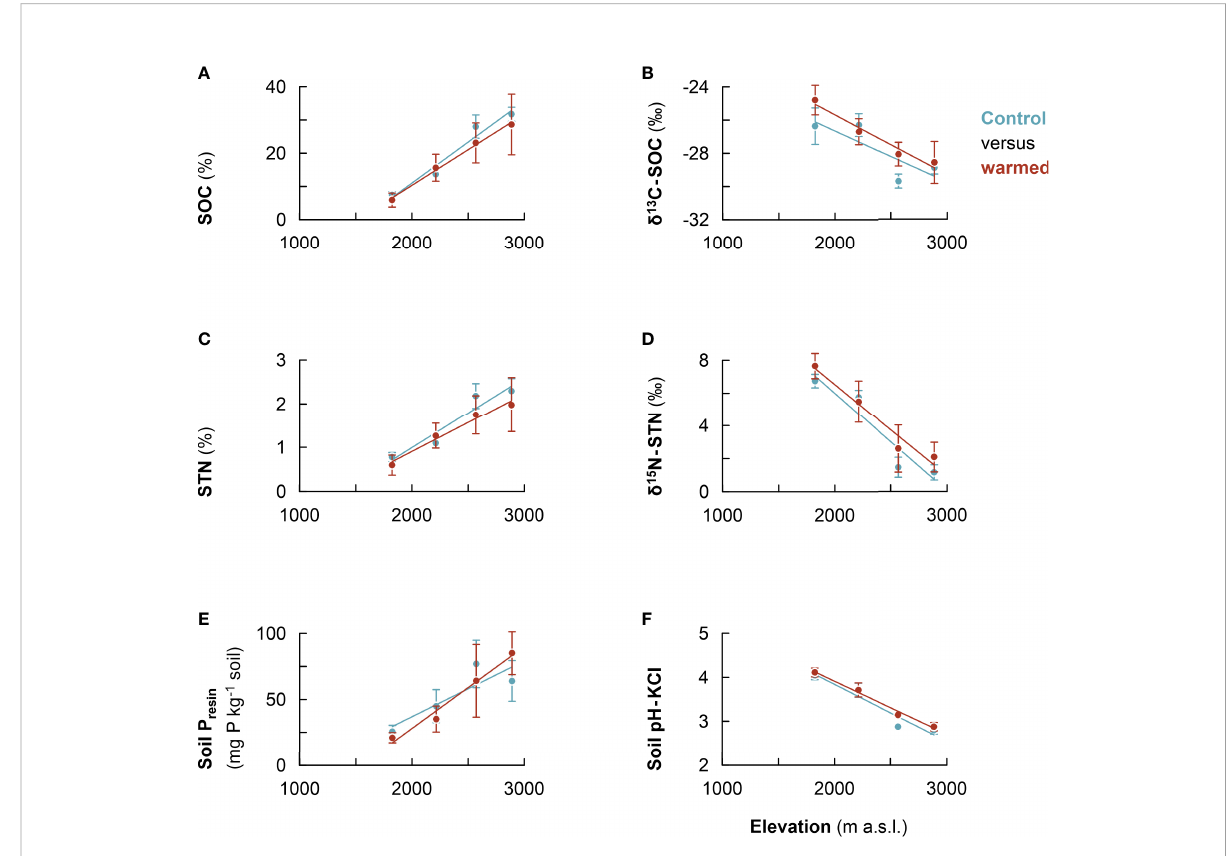
FIGURE 4 Warming response of soil chemical properties along the Rwenzori elevational gradient; soil organic carbon (SOC) (A) , soil d 13 C (B) , soil total nitrogen (STN) (C) , soil d 15 N (D) , soil resin P (E) , and soil pH-KCl (F) . Warmed soil (red line) and control (blue line). Mean values were calculated from composite soil samples per elevation cluster (n = 4). The error bars indicate the standard deviation from the